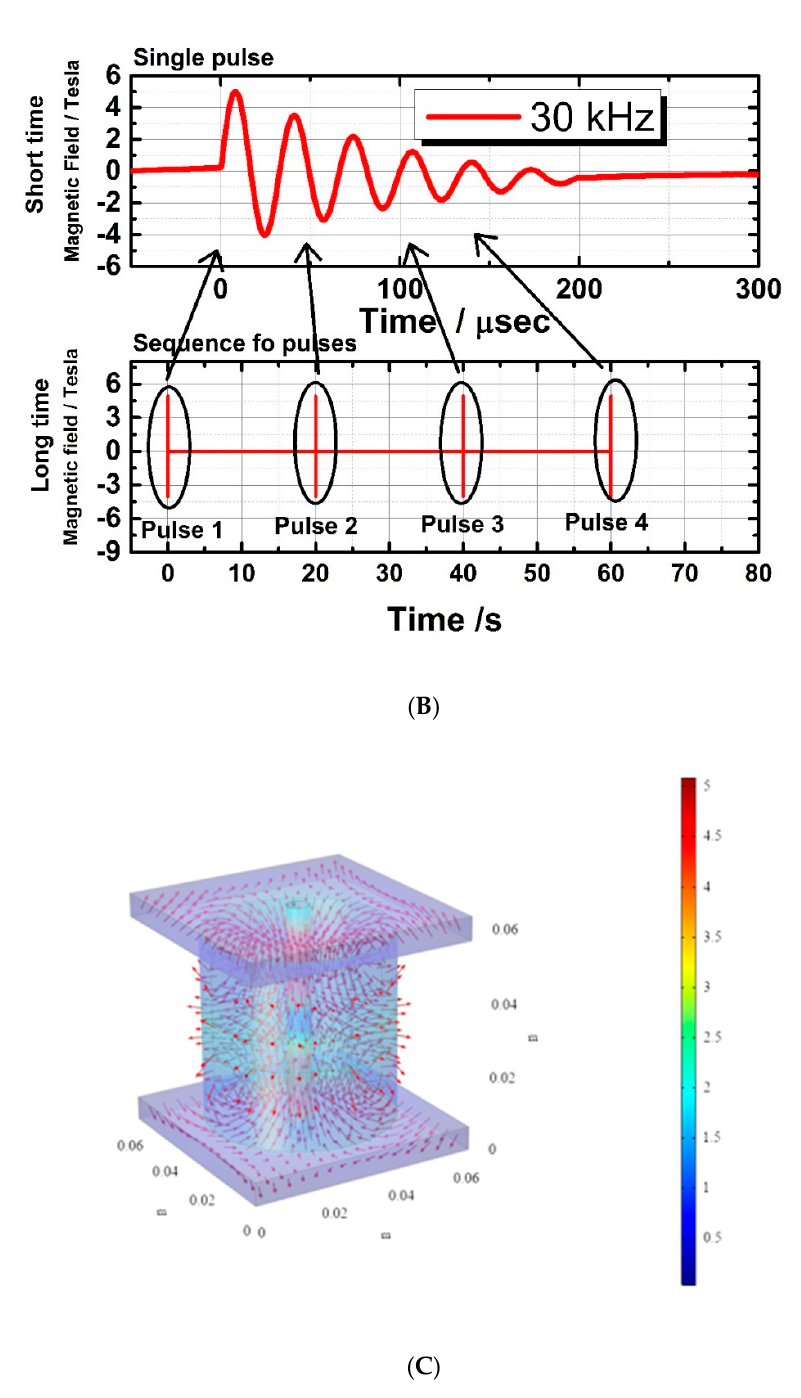
Figure 7. ( A ) Integrated pulsed magnetic field and temperature dependent PL measurement system. For magnetic field exposure, the sample was lowered into a temperature-controlled metal block. PL was monitored with the help of Raman fluorescence probe. ( B ) The upper graph shows the magnetic pulse in one of the coils of the anti-Helmholtz coil pair and the graph below shows the sequence of the magnetic pulses as they are applied. ( C ) The magnetic vector field inside the coil modelled with COMSOL multiphysics software. The scale bar shows the intensity of the magnetic field in Teslas. The sample was placed in the center of this magnet where the magnetic field was zero, but the magnetic field gradient was large (~800 Tesla/m) The sample with small sample volume was placed in the center of the coil for the experiments.